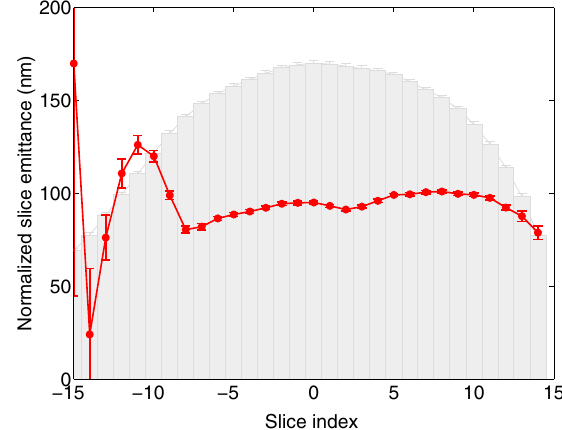
FIG. 60. Normalized slice emittance measured with the Swiss- FEL gun for a bunch charge of 20 pC (red). The longitudinal charge profile is shown as gray bars.